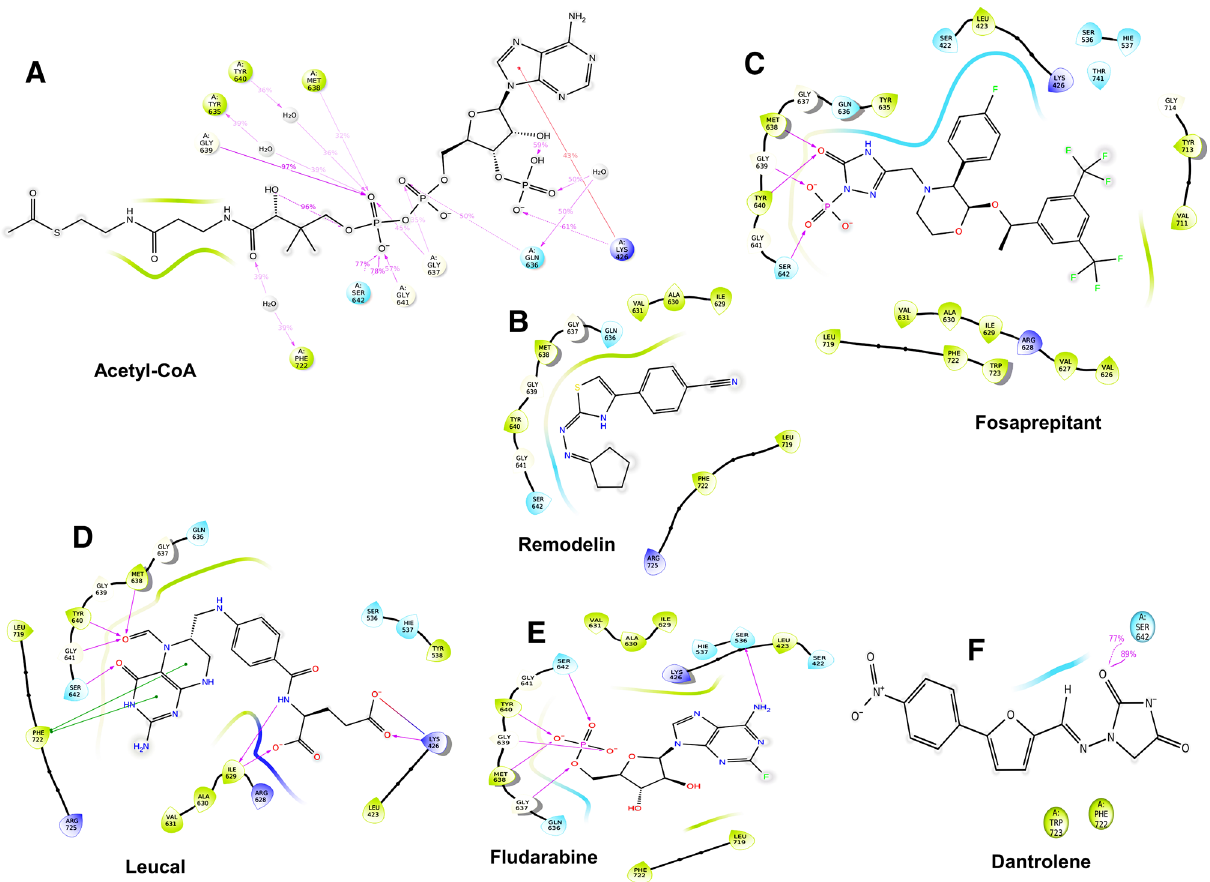
Figure 2. Interaction diagram of NAT10 residues from acetyl-CoA binding pocket with ligands. ( A ) Acetyl- CoA ( B ) Remodelin ( C ) Fosaprepitant ( D ) Leucal ( E ) Fludarabine ( F )